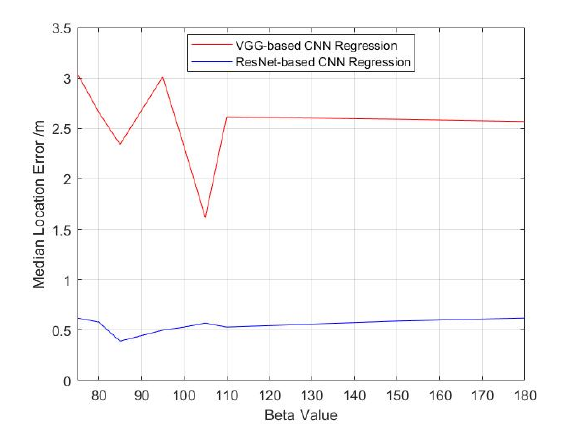
Figure 6. Median Positioning error with different β values